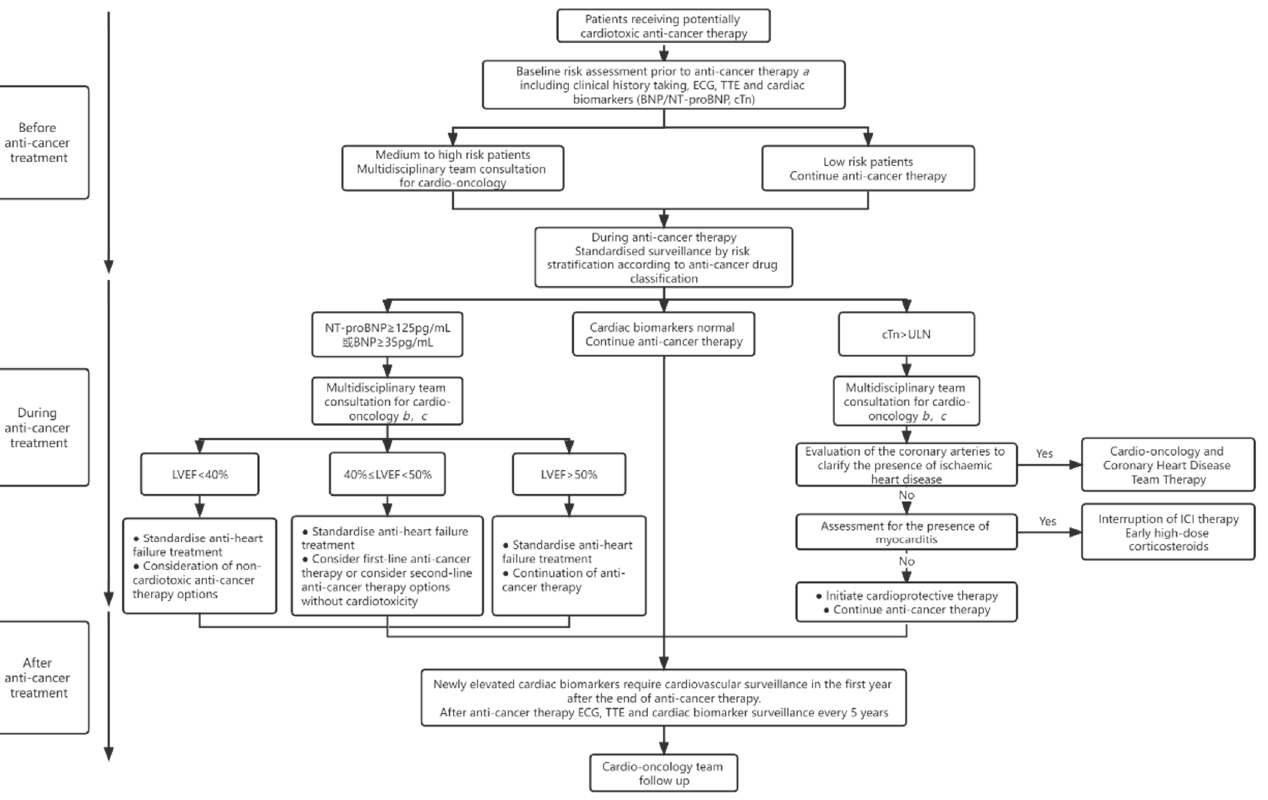
Figure 1. Management strategies for patients receiving potentially cardiotoxic anti-cancer therapy.